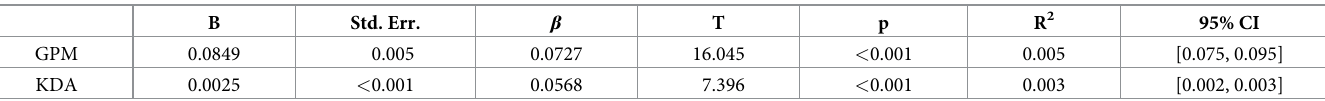
Table 2. Linear regressions of time delta in days between 1st and 95th match on average GPM and KDA between the 96th and 100th match. B Std.